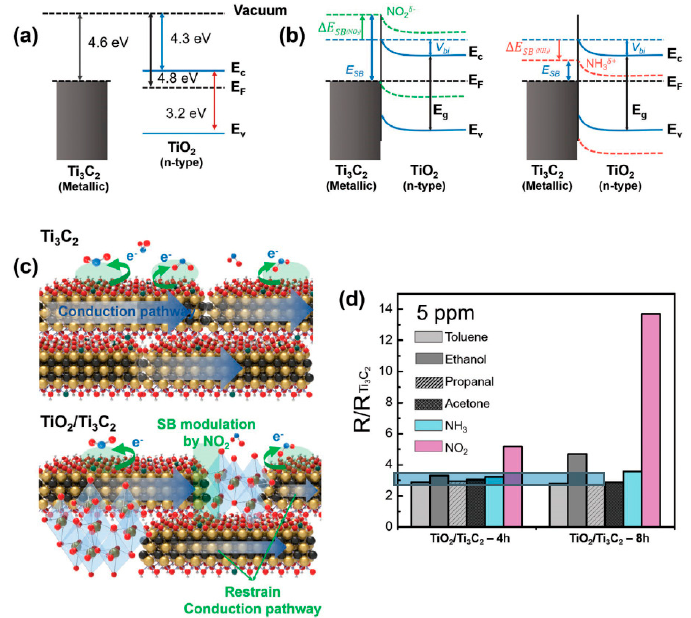
Figure 9. ( a ) A schematic illustration of work function and Fermi level position for Ti 3 C 2 metallic channel and TiO 2 semiconductor. ( b ) Schottky barrier modulation upon exposure to NO 2 and NH 3 gases. ( c ) Gas-sensing mechanism toward NO 2 gas for Ti 3 C 2 and TiO 2 /Ti 3 C 2 films. ( d ) Enhancement factor of gas response for TiO 2 /Ti 3 C 2 compared with pristine Ti 3 C 2 at 5 ppm gas concentration. Reprinted with permission from [103]. Copyright 2020: Wiley-VCH GmbH.